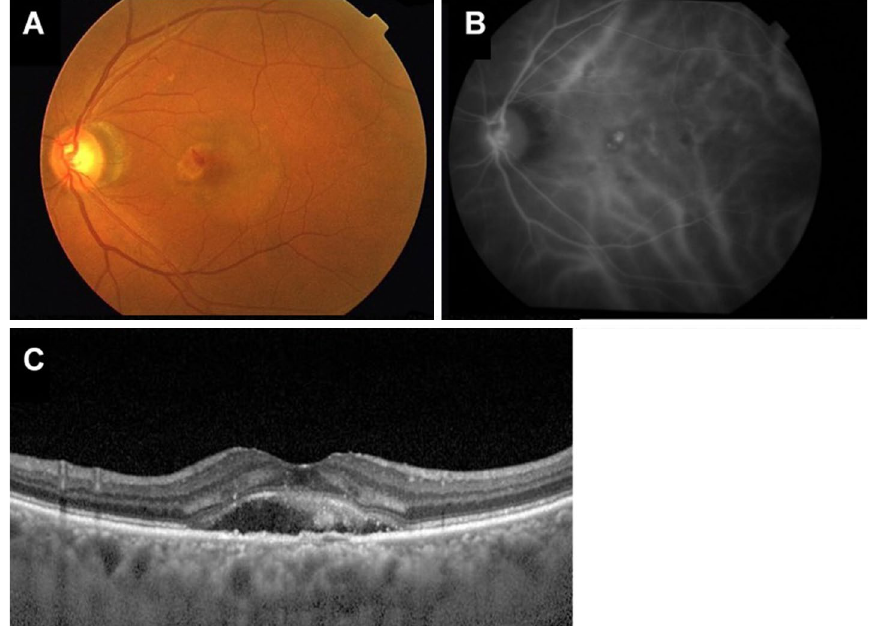
Figure 3. Fundus photograph of 76-year-old man with pachychoroid neovasuculopathy (PNV). ( A ) Drusen are not present in the fundus photograph. ( B ) Indocyanine green angiography (ICGA) showing increased choroidal vascular permeability. The dilated blood vessels pass through the areas close to the macula. ( C ) The central choroidal thickness (CCT) is 335 μm and the choroidal vessel diameter (CVD) is 201 μm. Choroidal vessels in Haller’s layer are